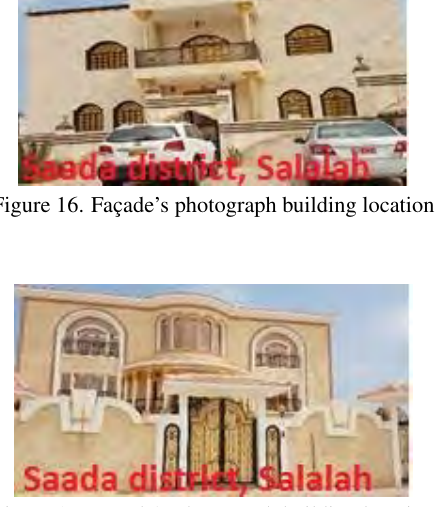
Figure 17. Fac¸ade’s photograph building location